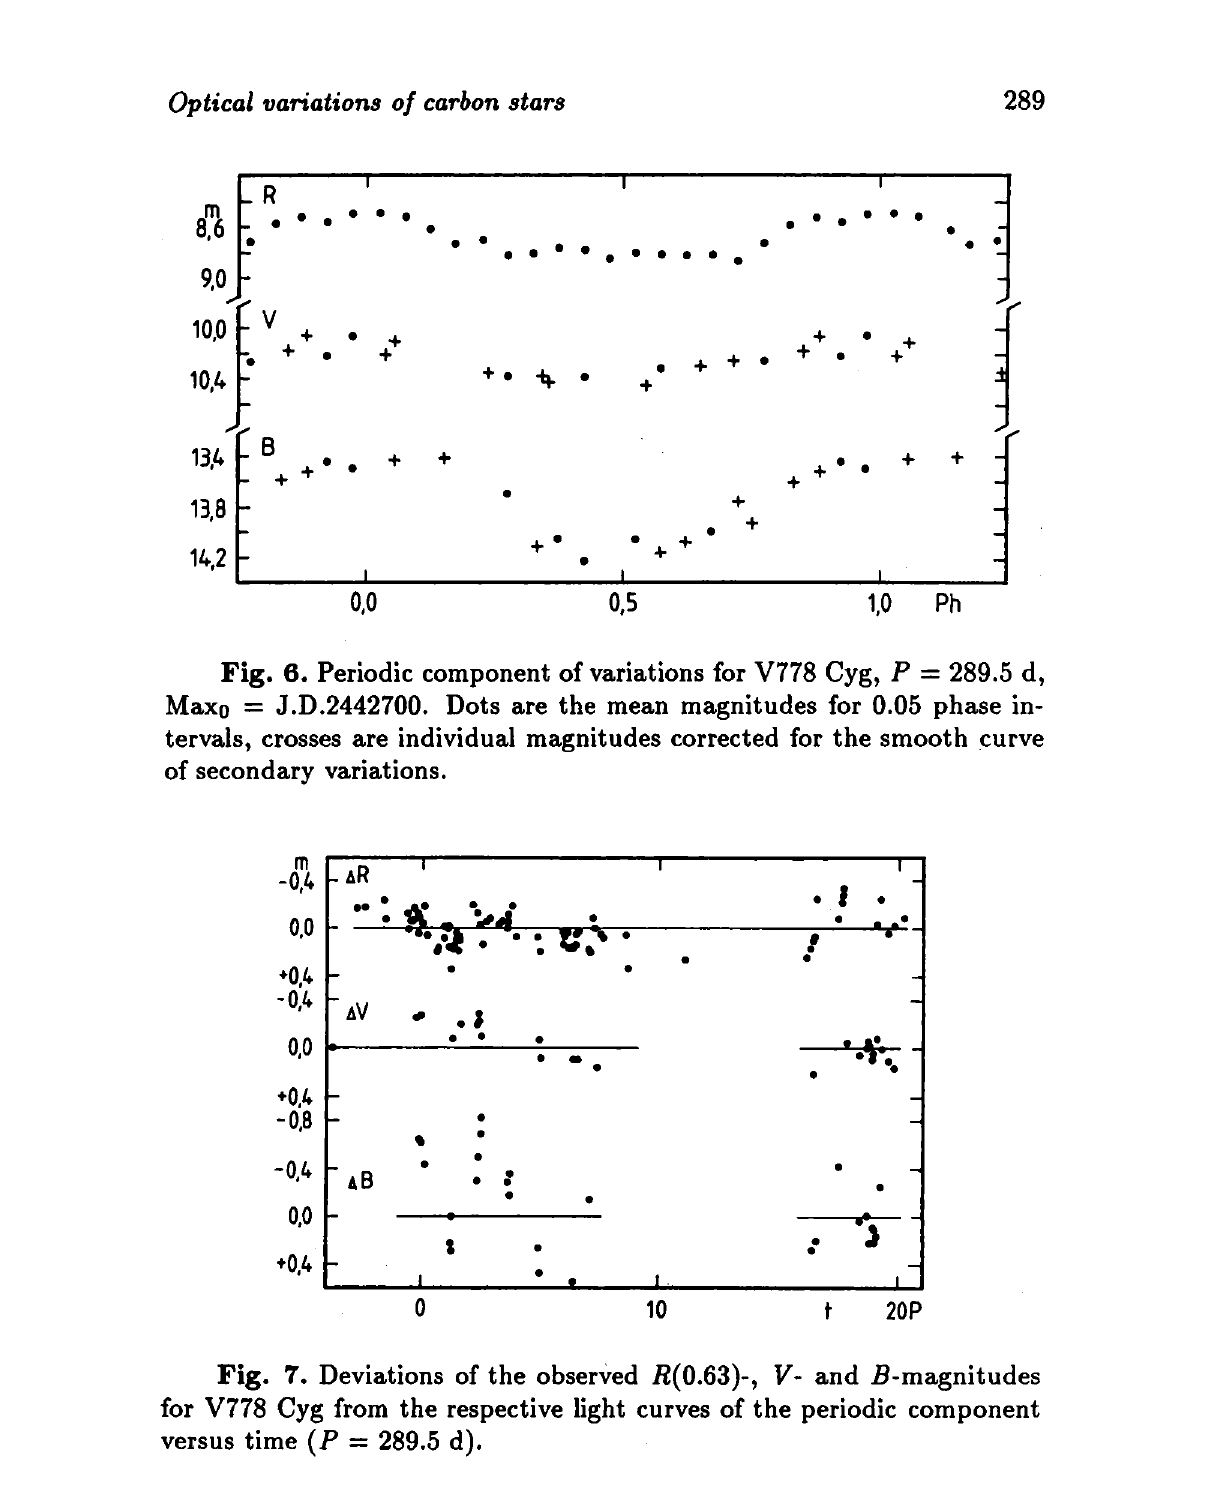
Fig. 7. Deviations of the observed ß(0.63)-, V- and 5-magnitudes for V778 Cyg from the respective light curves of the periodic component versus time (P = 289.5